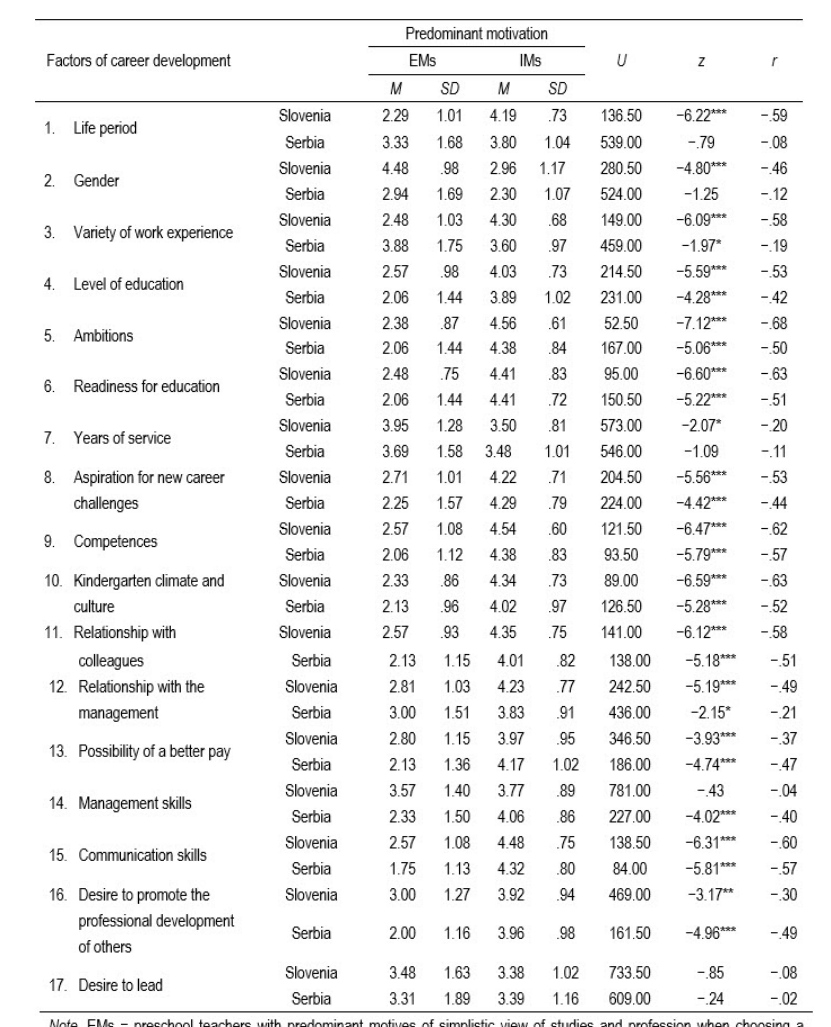
Means, standard deviations, and Mann-Whitney test for individual items of the Factors of Career Development